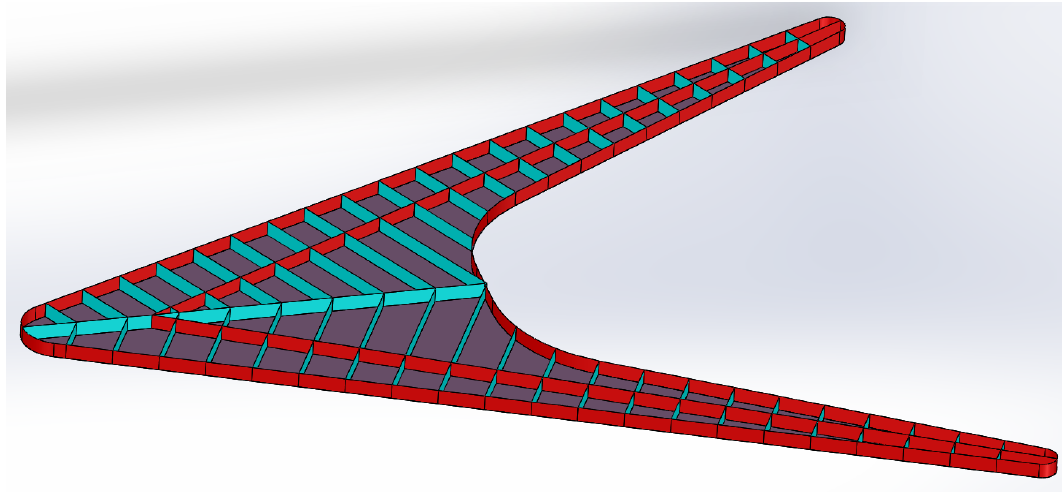
Figure 16. Compartment division on a single floor. Each compartment is about 30 m in length.